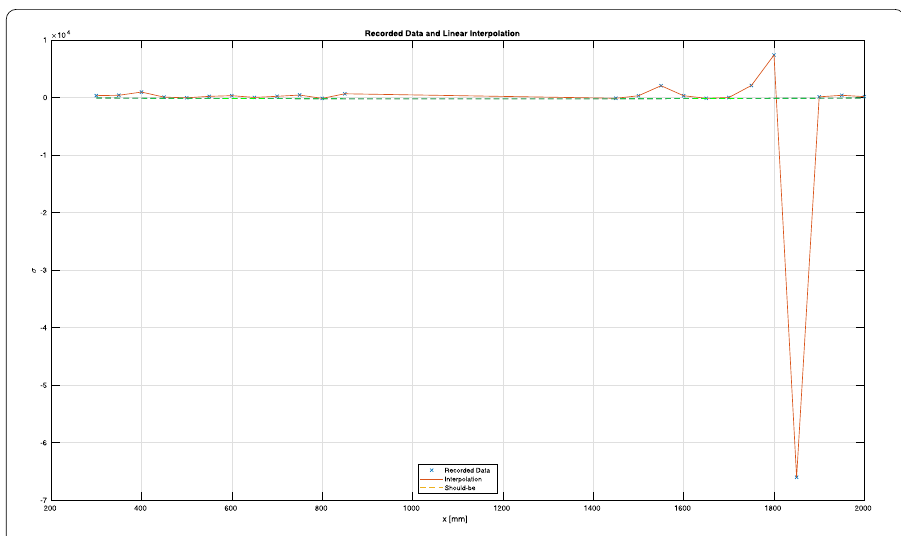
Figure 16 The non-scaled initial data. Several outliers due to dramatically missevaluated AScans are obvious and corrected in a preprocessing step before further estimation